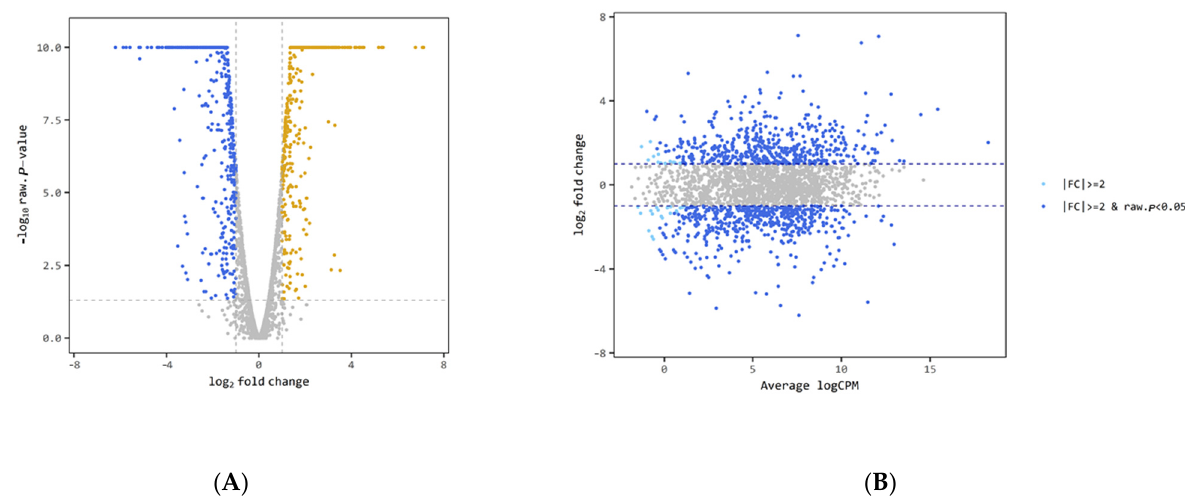
Figure 4. Differential expression level of the biofilm vs. planktonic identified by | log2 (fold change)| > 1 and adjusted p -value < 0.05. ( A ) volcano plot, ( B ) smear plot.